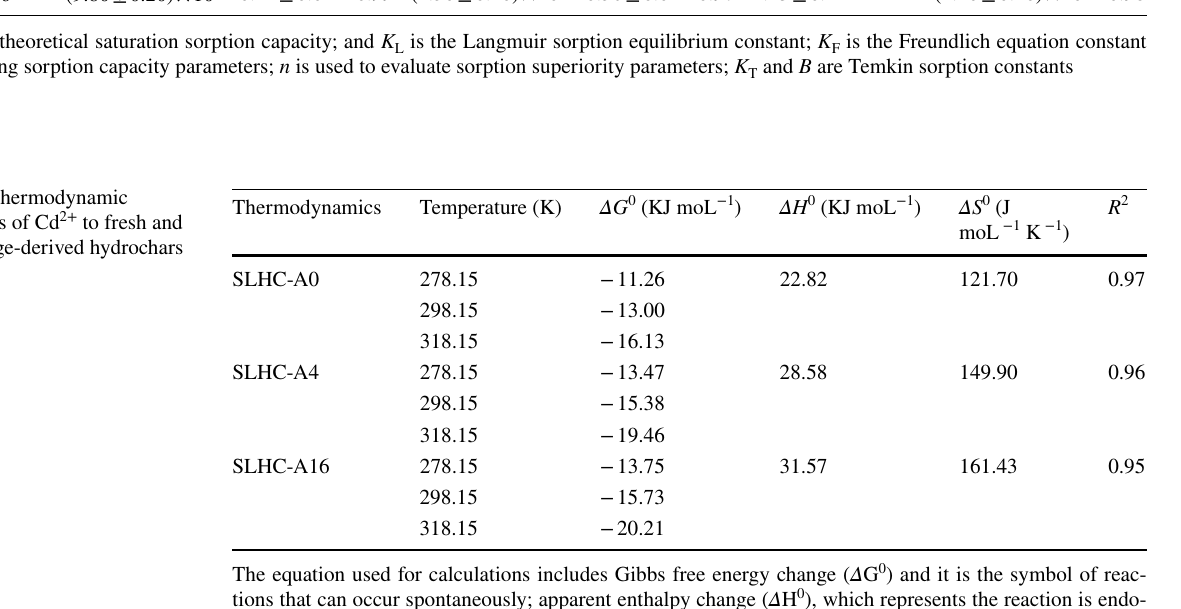
The equation used for calculations includes Gibbs free energy change ( Δ G 0 ) and it is the symbol of reac- tions that can occur spontaneously; apparent enthalpy change ( Δ H 0 ), which represents the reaction is endo- thermic; apparent entropy change ( Δ S 0 ) and it shows the reaction system chaotic